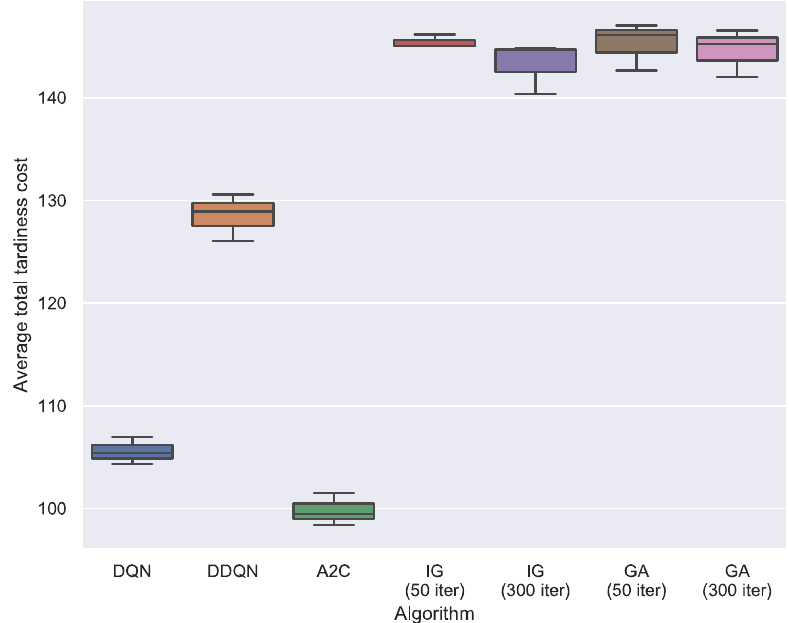
Figure 7. Average total tardiness cost of compared algorithms on all test instances. Three replica- tions are carried out for each test instance. IG and GA are tested under two search iteration levels, 50 iterations and 300